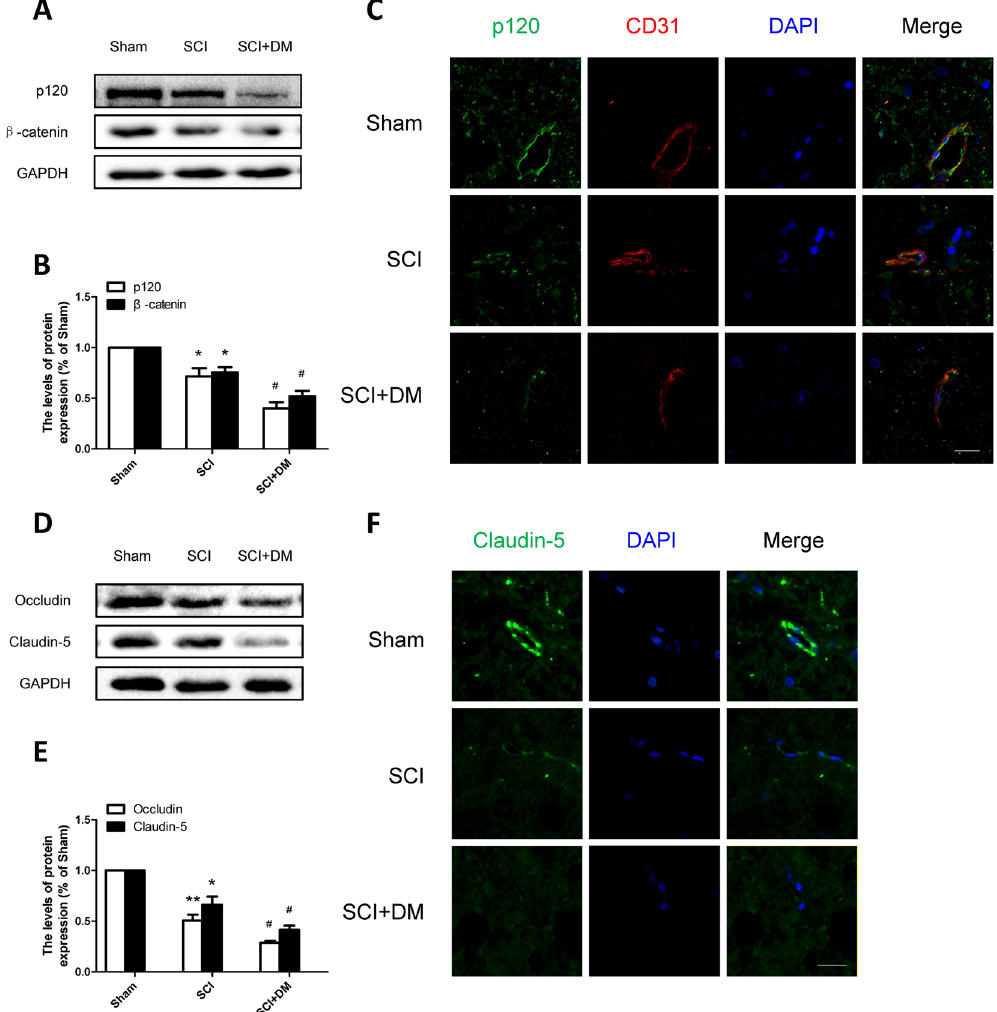
Figure 3. DM aggravates the loss of TJ and AJ proteins after SCI. ( A , B ) Western blot and quantification of p120 and β -catenin in each group, n = 6. ( C ) Immunofluorescence staining of p120 and CD31 in each group, n = 4. Scale bar = 10 μ m. ( D , E ) Western blot and quantification of Occludin and Claudin-5 in each group, n = 6. ( F ) Immunofluorescence staining of Claudin-5 in each group, n = 4. Scale bar = 10 μ m., * p < 0.05, ** p < 0.01 vs sham group, # p < 0.05 vs SCI